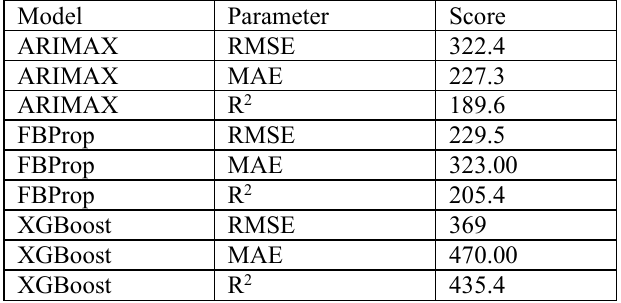
Table 6. Comparative Performance of Each Model